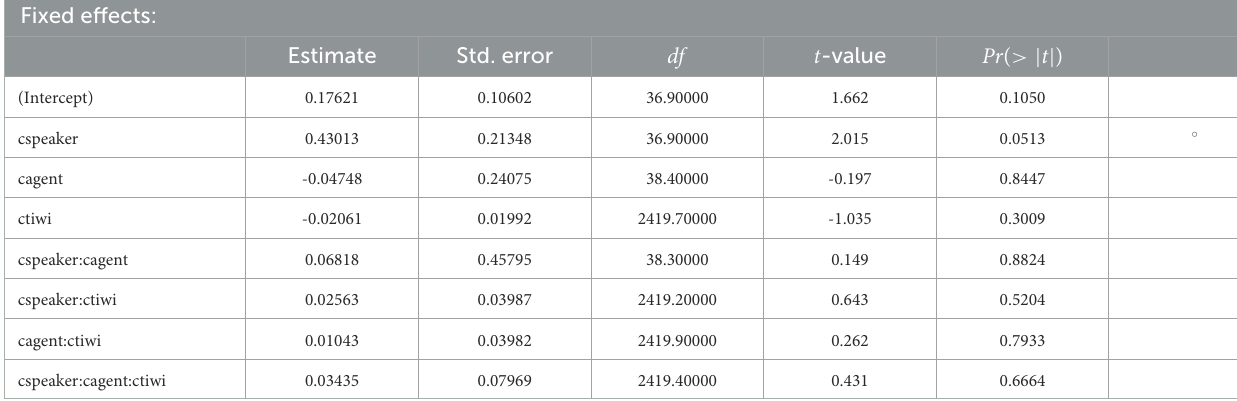
TABLE 3 Coefficients, SE s, df s, t -values, and p -values for the optimal model of logratios of target fixations for the shift time window for Experiment 2.